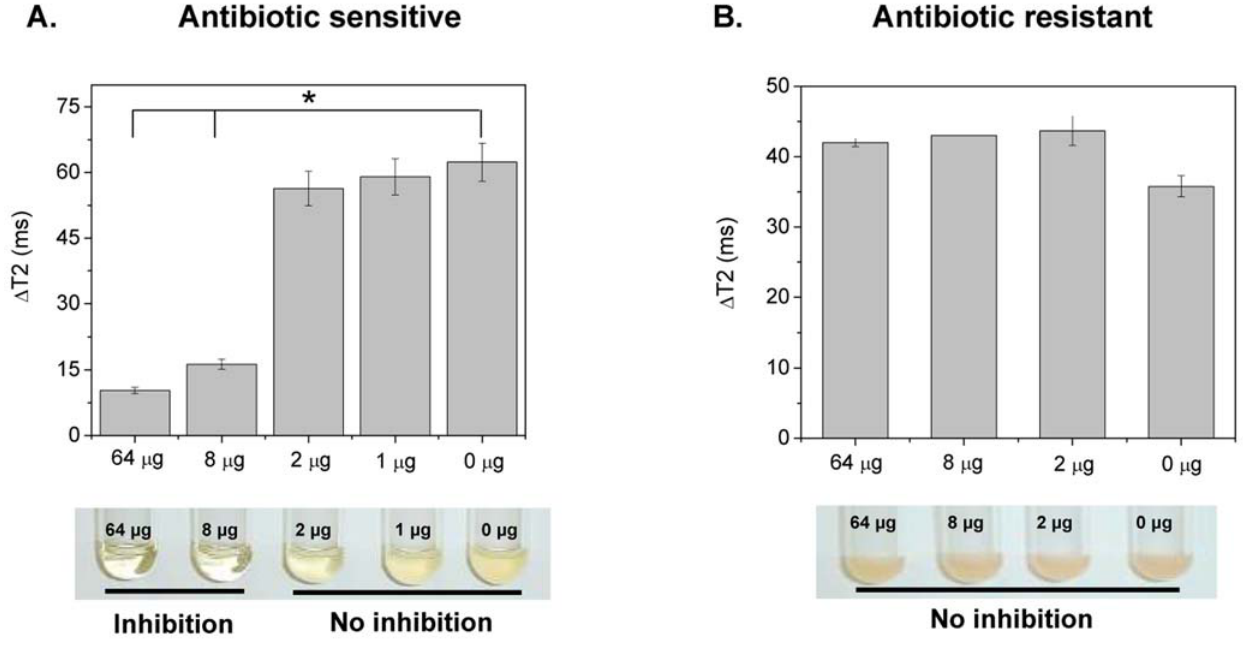
Figure 3. Antimicrobial susceptibility screening in MH broth with dextran-coated polysaccharide nanosensors. (A) Determination of E. coli ’s minimum inhibitory concentration in MH broth, using the changes in spin-spin relaxation times ( D T2, upper panel) (Means 6 SE; p , 0.05) and the turbidity method (lower panel). (B) Identification of S. marcescens ’ resistance to ampicillin via DT 2 (upper panel, Means 6 SE) and the turbidity assay (lower panel). The corresponding amount of ampicillin is indicated in the graphs and pictures of the bacterial cultures.